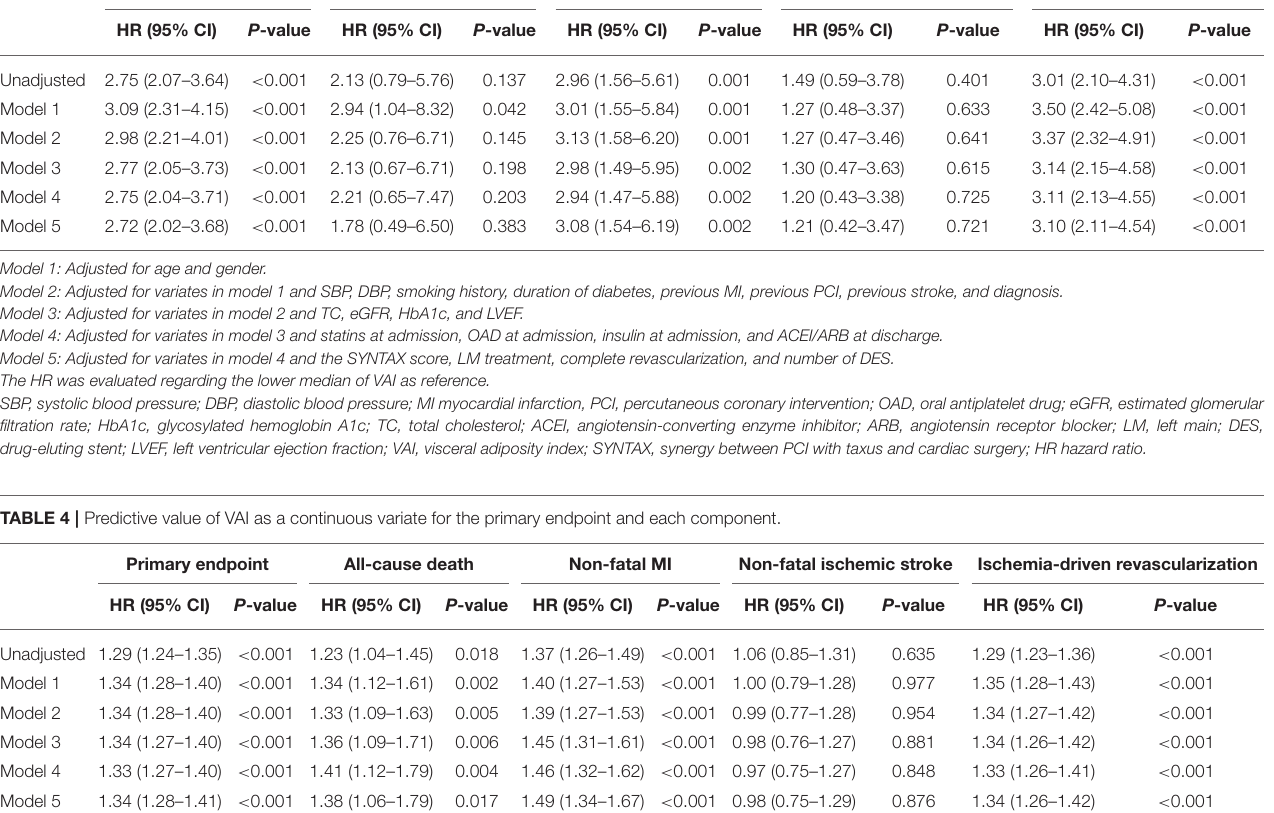
TABLE 3 | Predictive value of VAI as a nominal variate for the primary endpoint and each component. Primary endpoint